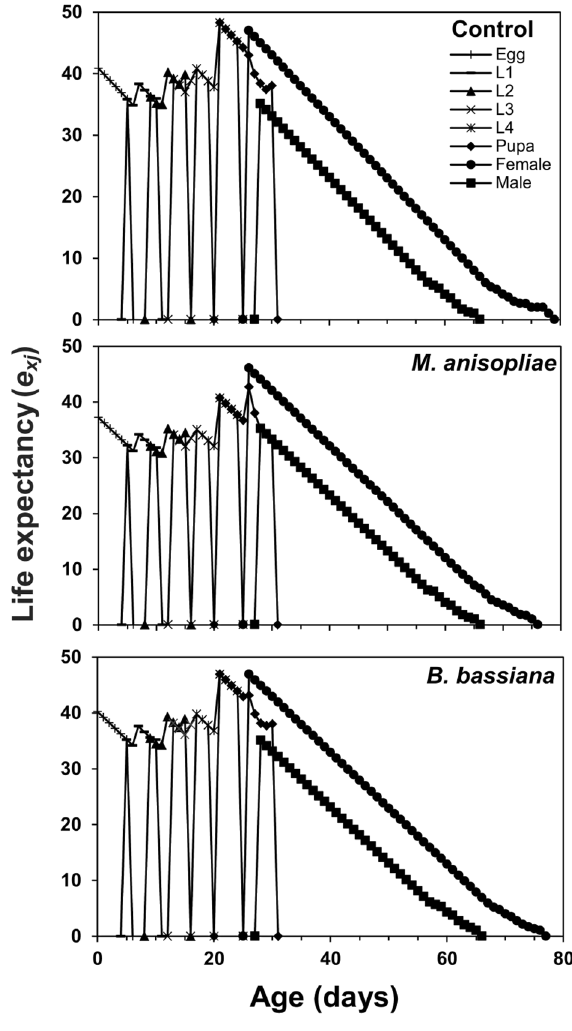
Figure 2. Age-stage–specific life expectancy ( e xj ) of Coccinella septumpunctata after exposure of entomopathogenic